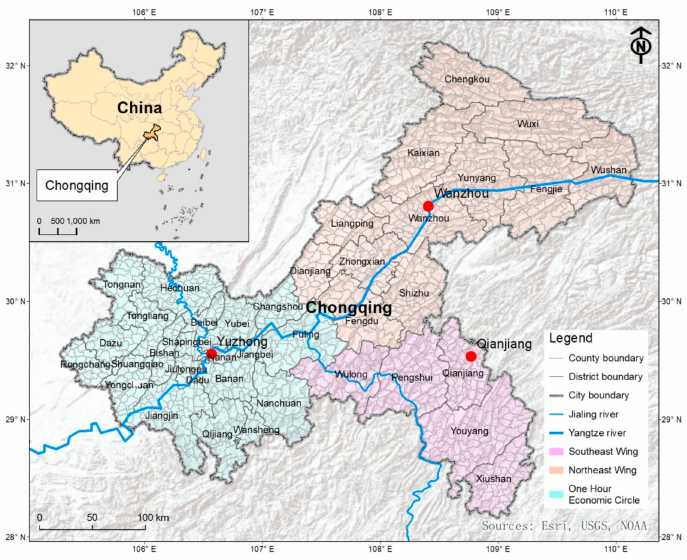
Figure 1. Location and spatial structure of Chongqing; Source: edited by authors. Complex in topography, Chongqing encompasses vast territory, dominated by moun- tains and hills (accounting for 75.8% and 18.2% of total area, respectively) with rich natural vegetations. Its unique geographical milieu and subtropical climate zone location pro- vide beneficiary conditions for diverse forest development, e.g., subtropical evergreen broad-leaved forest, deciduous broadleaf forest, mixed forests of the former two and warm coniferous forest, etc., producing prominent effects on ecological conservation. Within Chongqing’s jurisdiction, the main tree species include mason pine, fir, cypress, oak, birch and poplar, etc. that are widespread planted in Mountain Wuling, Jinyun, Simian, and Jinfo. Being one of China’s largest metropolises, Chongqing entrusted with demonstration task of urban–rural coordination is characterized by a “One Circle, Two Wings” metropoli- tan structure, offering the spatial framework for analysis of forest transition. In this struc- ture, One Circle refers to the economically advanced urban functional core/development area while Two Wings indicate the northeast wing of ecological conservation develop- ment area and the southeast wing of ecological protection area (Figure 1). In this figure, the boundaries with dark gray refer to districts or counties at the bureau level (tingju ji) and the boundaries with light gray refer to towns, villages or streets within the districts or coun- ties. There are 39 districts/counties and roughly more than 1000 villages/towns/streets in